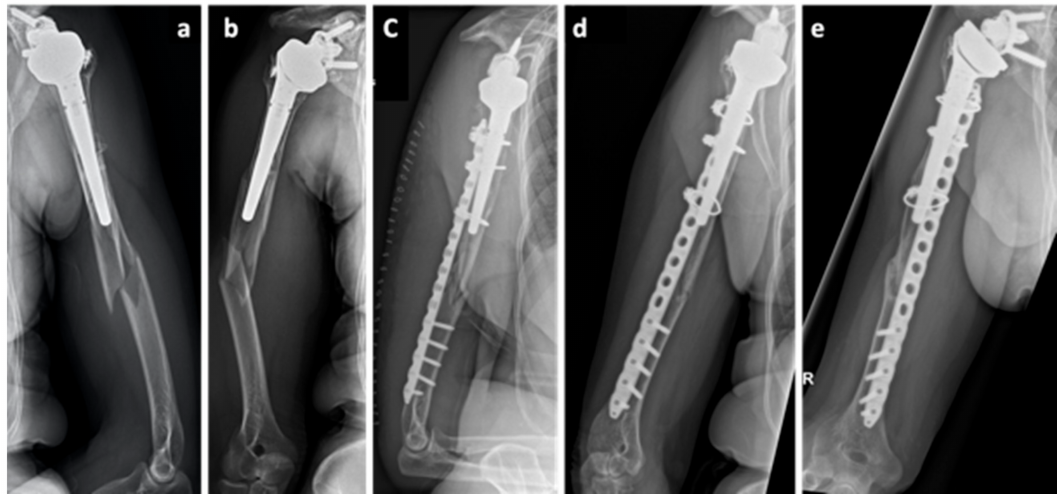
Figure 3. Case 3, x-ray showing the initial periprosthetic humeral fracture (UCS I.1B1) ( a , b ), the initial postoperative radiograph ( c ), delayed union 6 months after trauma ( d ) and bone union at the end of the teriparatide treatment, 12 months after trauma ( e